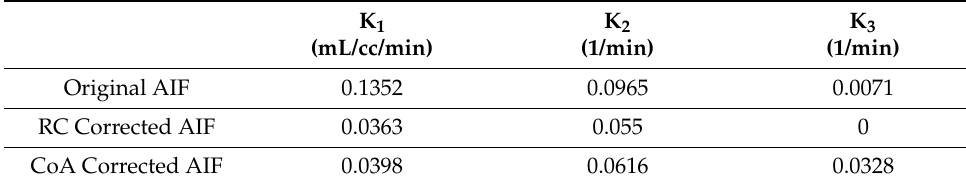
Table 2. Effect of AIF correction on kinetic model